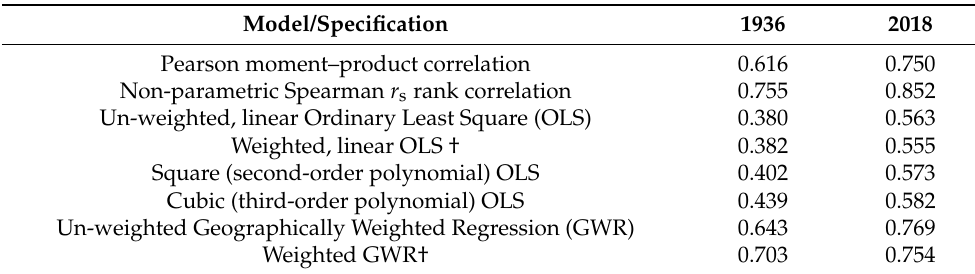
Table 1. Correlation coefficients and best-fit R 2 of global econometric models (Ordinary Least Squares (OLS) with linear and non-linear specifications; Geographically Weighted Regression (GWR) estimating the percentage of forest area in each spatial domain (dependent variable) from the distance to downtown Rome (predictor) by year.